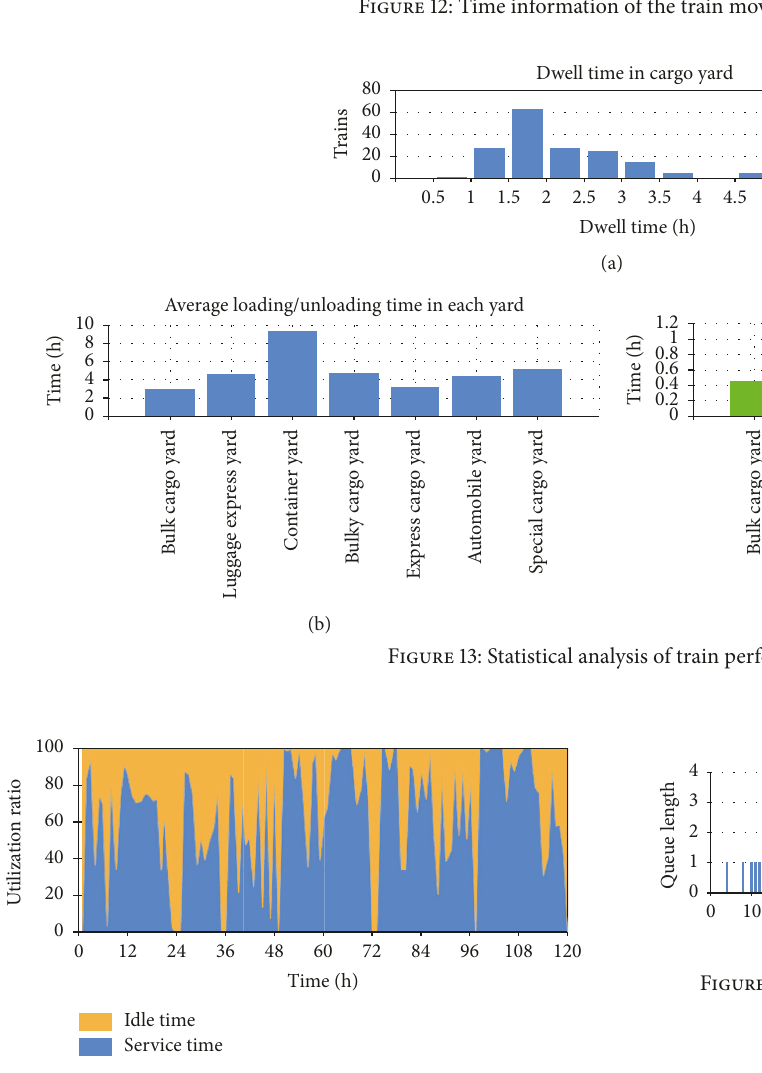
Figure 14: Crane utilization ratio in container yard.